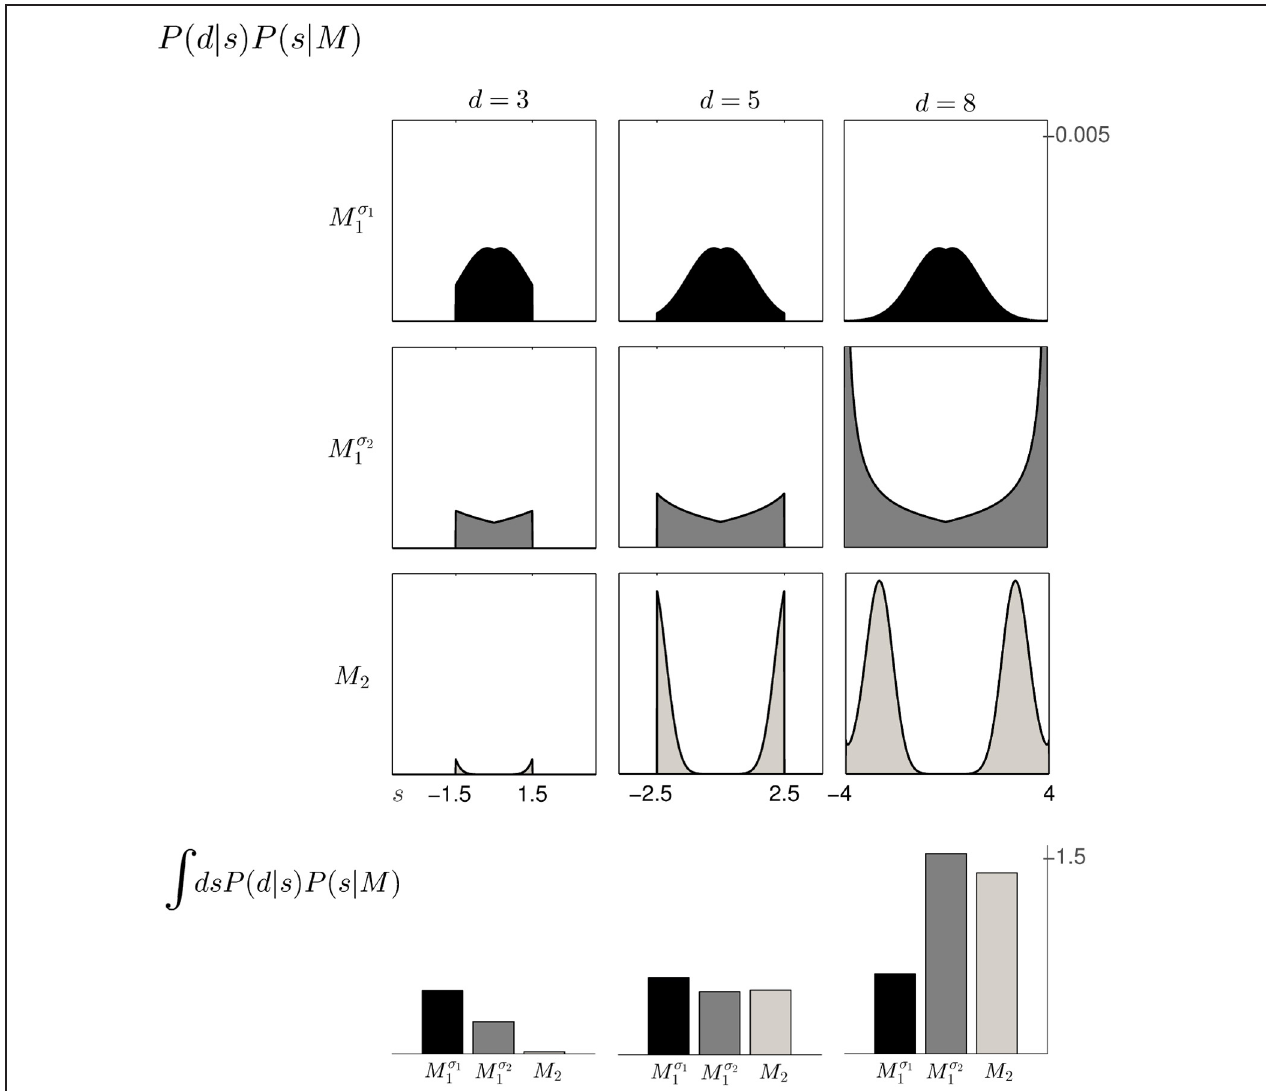
the shift s for each of the three models within the same column. For feedback arrays of large width ( d = 8cm), model M 2 is a better explanation than model M σ 1 1 . However, when increasing the standard deviation of M 1 to σ 2 both models have similar marginal likelihood for large width. For a detailed illustration on the computation of the model evidence P ( d | M ) see Figure 5